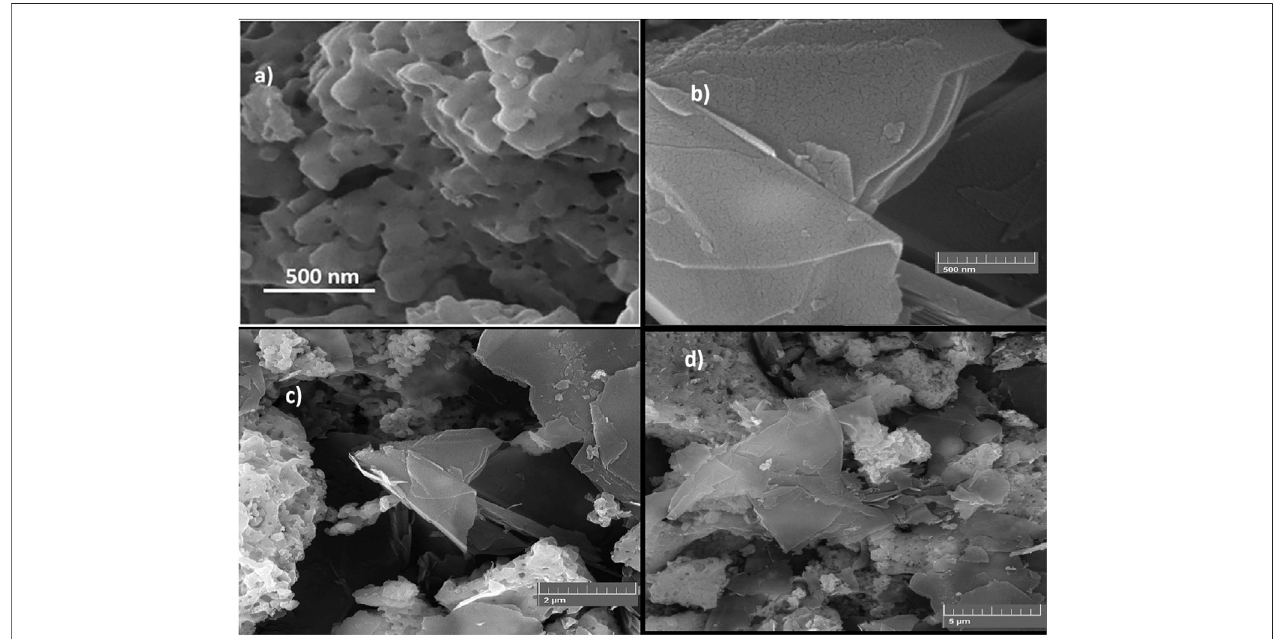
FIGURE 2 | (A – D) : SEM image of (A) Mn 2 O 3 , (B) graphene, and (C – D) Mn 2 O 3 /graphene composite.